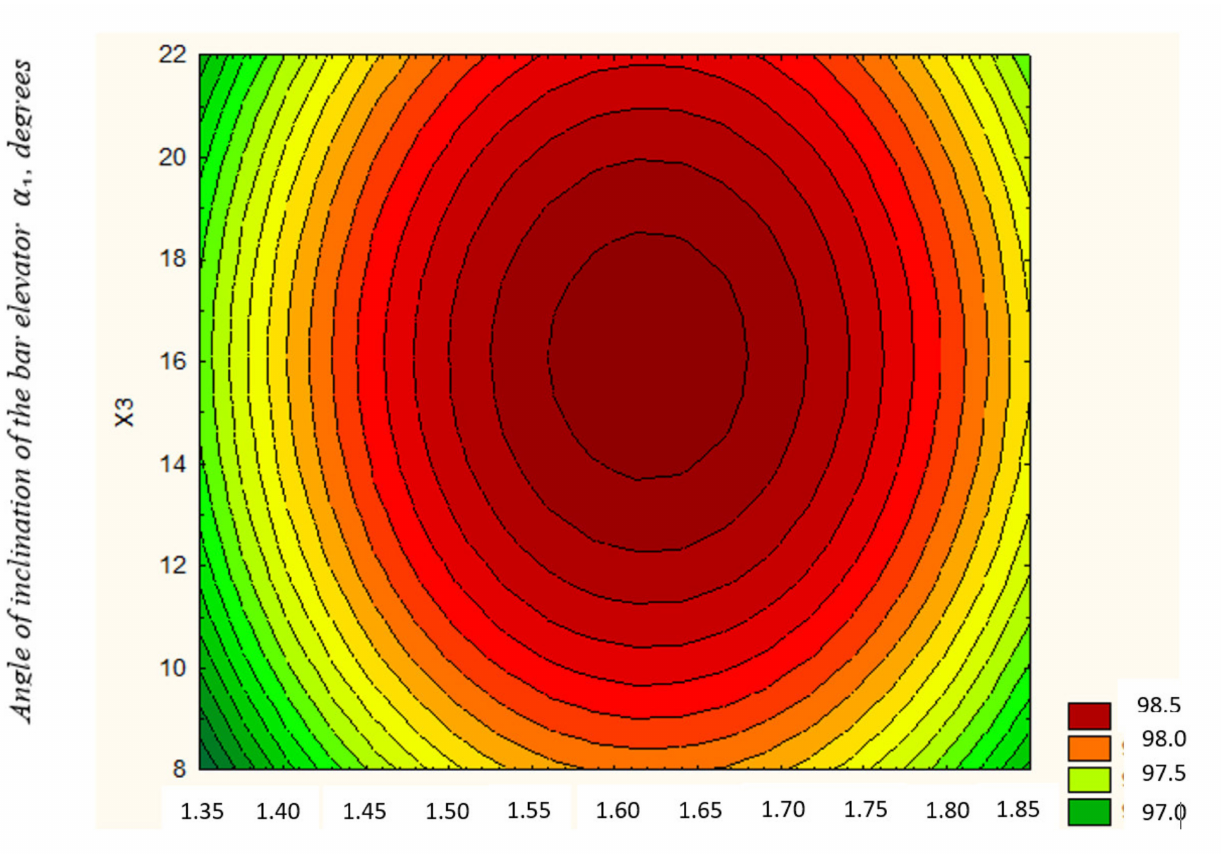
Figure 14. Two-dimensional cross-section of the response surface, characterizing the dependence of the completeness of the separation of the pile of onions on the translational speed of the web of the rod elevator (m/s) and the angle of inclination of the web of the rod elevator